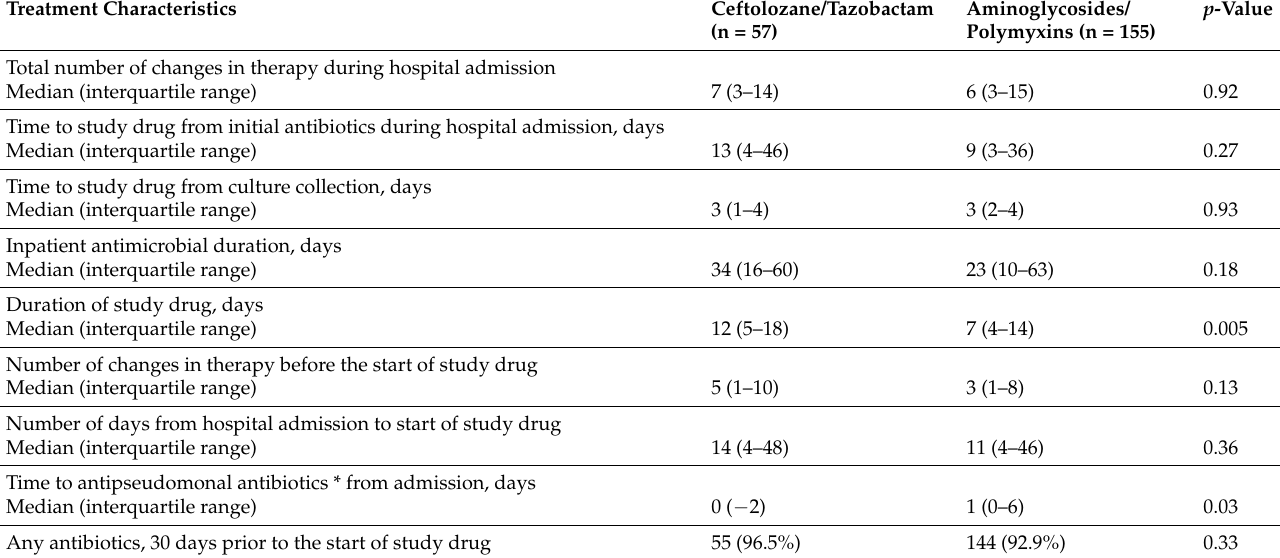
Table 2. Treatment characteristics of hospitalized patients with positive MDR Pseudomonas aeruginosa infections with ceftolozane/tazobactam or aminoglycoside or polymyxin treatment